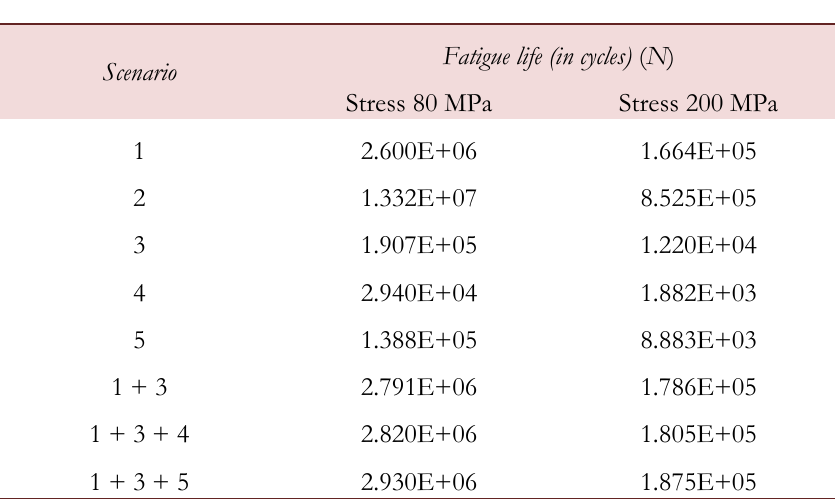
Table 11: Fatigue life for different scenarios.